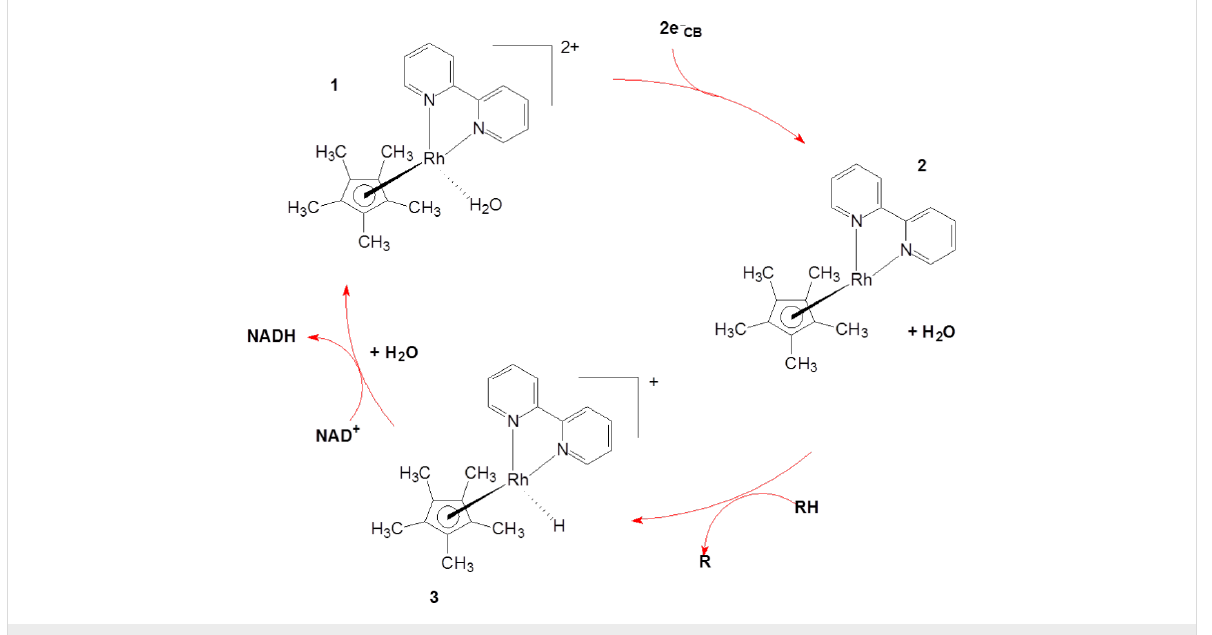
Figure 7: Expected role of the rhodium complex as an electron mediator.